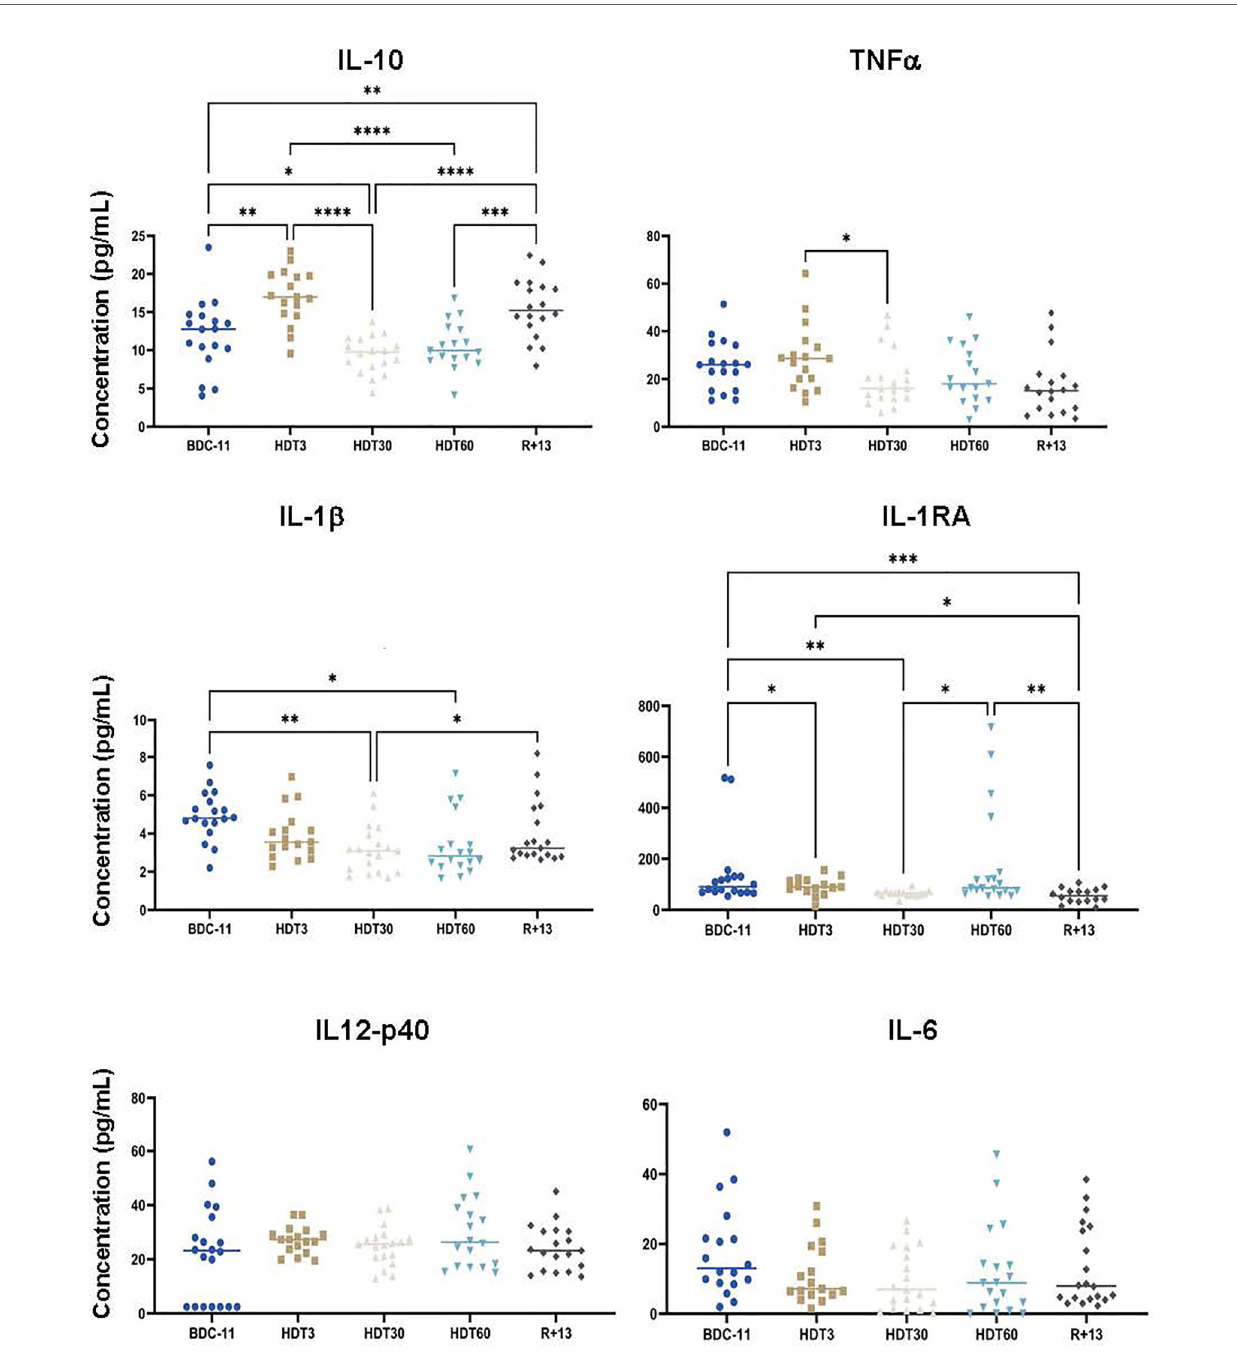
FIGURE 6 | Mean concentrations of serum pro- and anti-in fl ammatory cytokines before (BDC), during (HDT) and after (R) bed rest. As no statistically signi fi cant differences between the control and cocktail groups were observed, individuals of both groups were pooled. n = 17-20 except for IL-1RA where n = 15-19. Horizontal bars indicate the median. Statistically signi fi cant differences were shown using either one-way ANOVA or a linear mixed effects model analysis. *p < 0.05; **p < 0.01; ***p < 0.001, ****p < 0.0001. Assay sensitivities (pg/ml): IL-10, 1.1; TNF a , 0.7; IL-1 b , 0.8; IL-1RA, 8.3; IL-12p40, 7.4; IL-6,